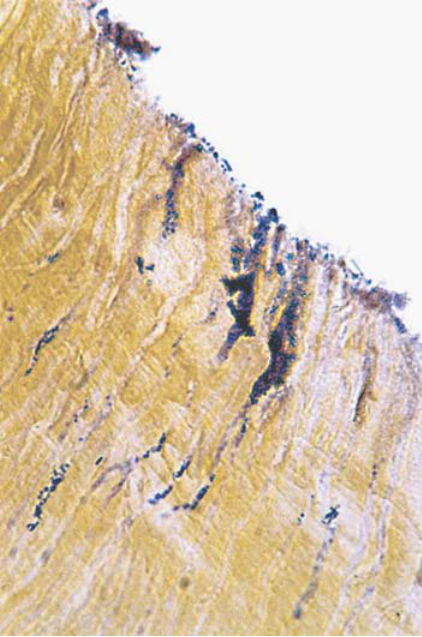
FIGURE 3- Apical delta containing microorganisms -